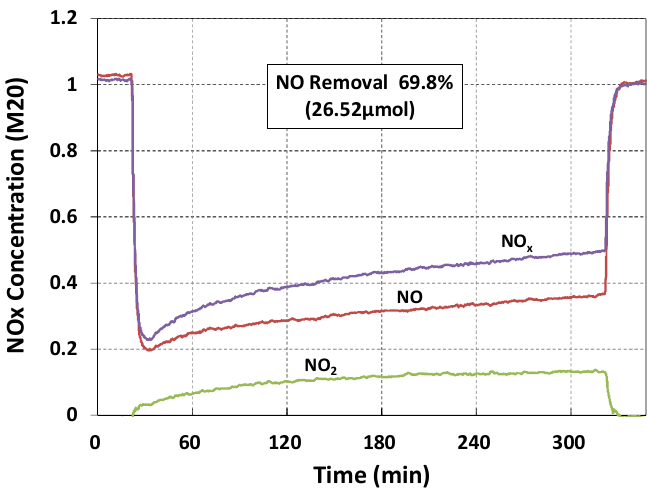
Figure 7. NO removal (ca. 70%) by M20.